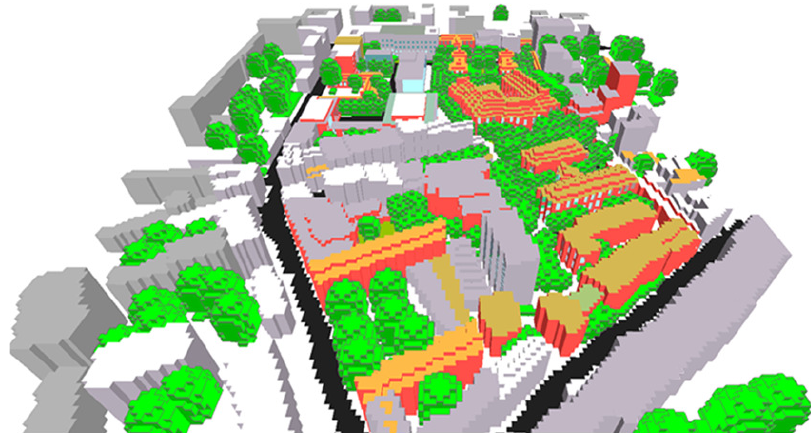
Figure 1. 3D representation of the case study from ENVI‐met. even if not directly measurable, these contributions will have health‐related impacts by increasing the climatic liveability of the area and then maintaining the human climate niche.